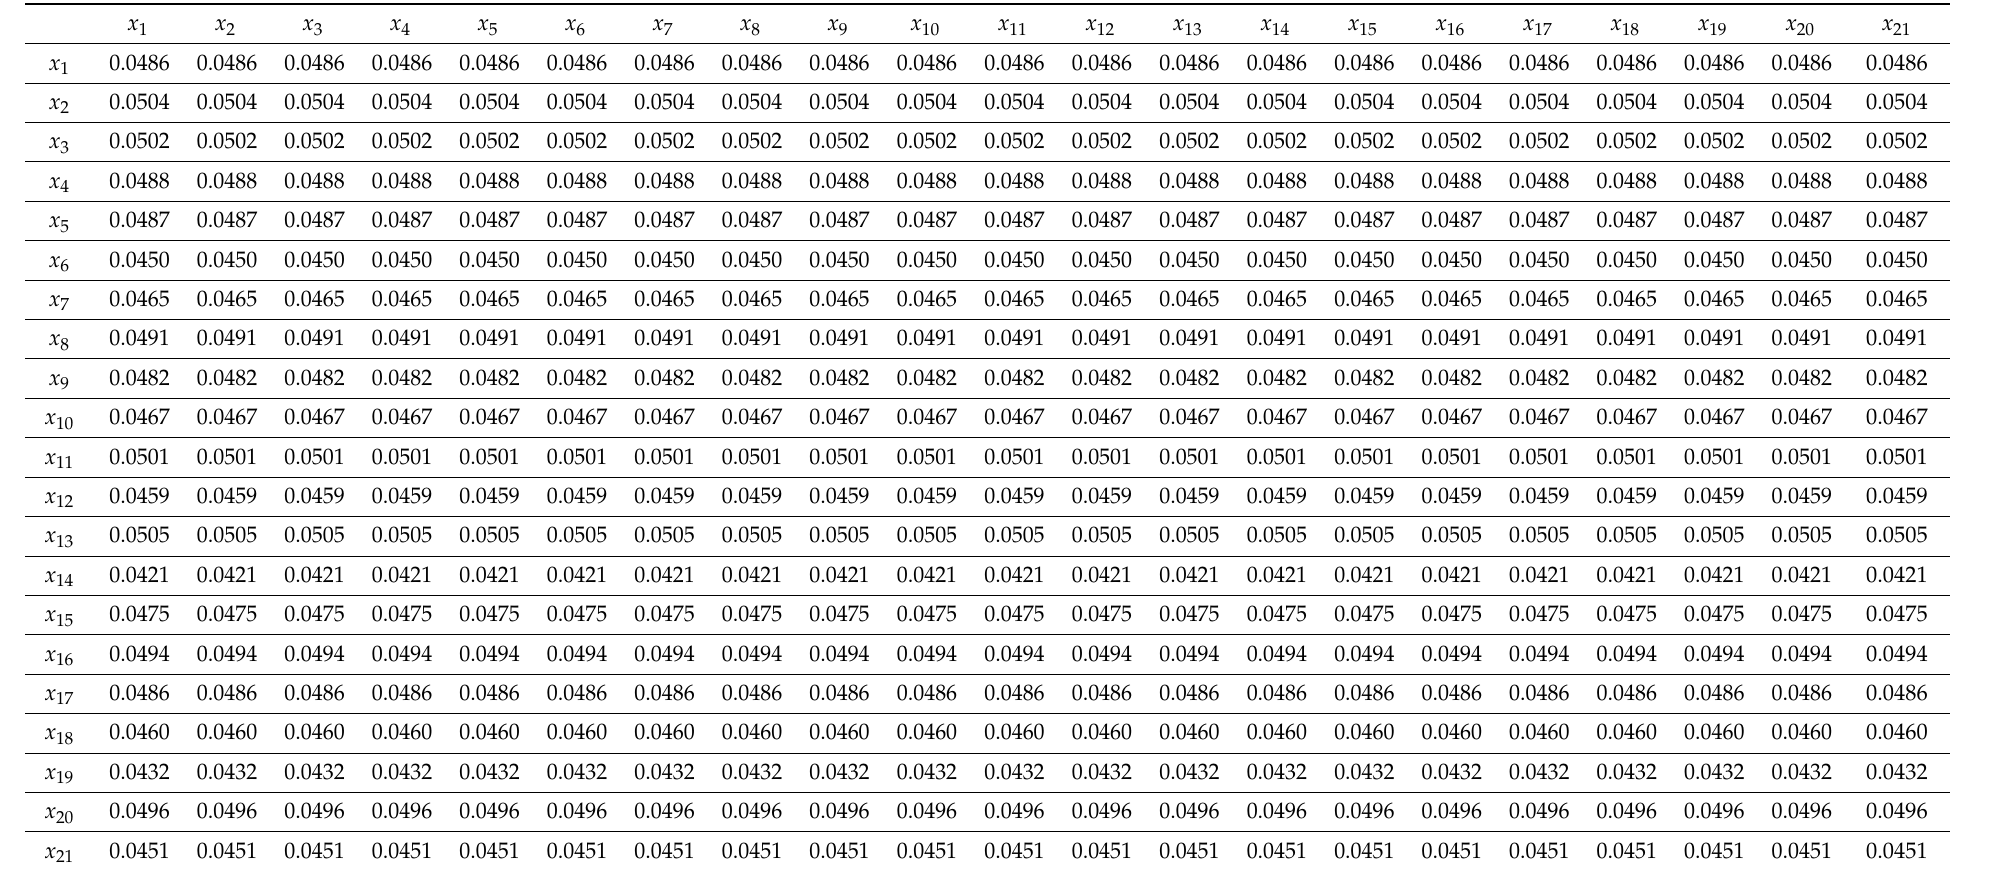
Table A6. The limited supermatrix for